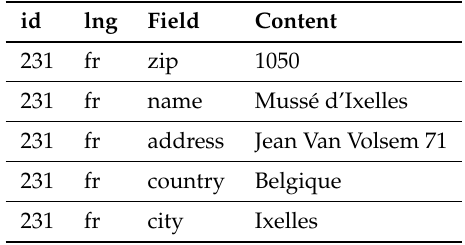
Table 2. Sample of the location_lng table of bozar database.